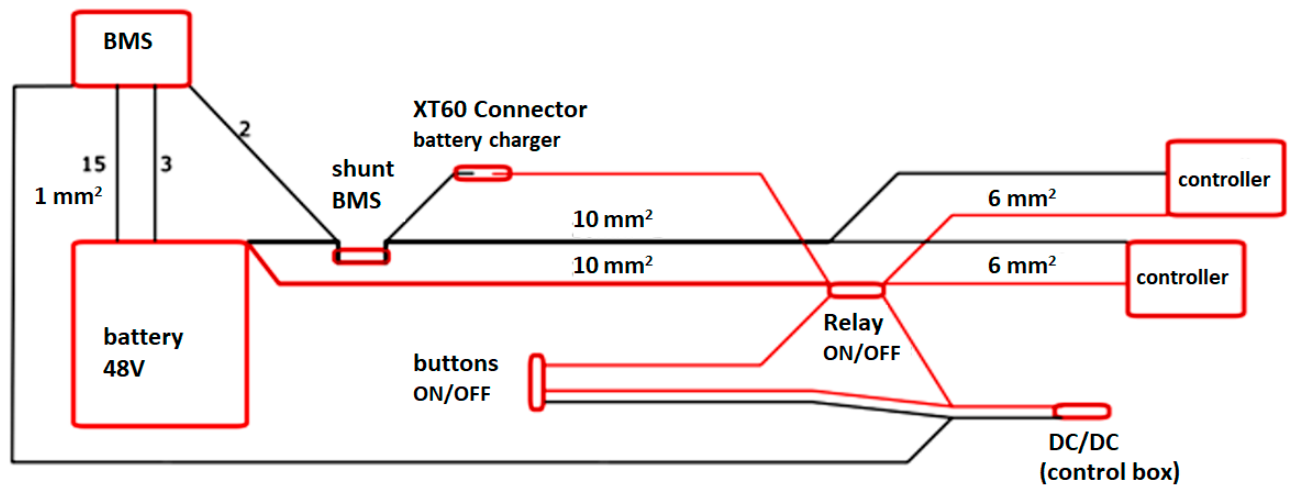
Figure 10. Electronic scheme of power connections.